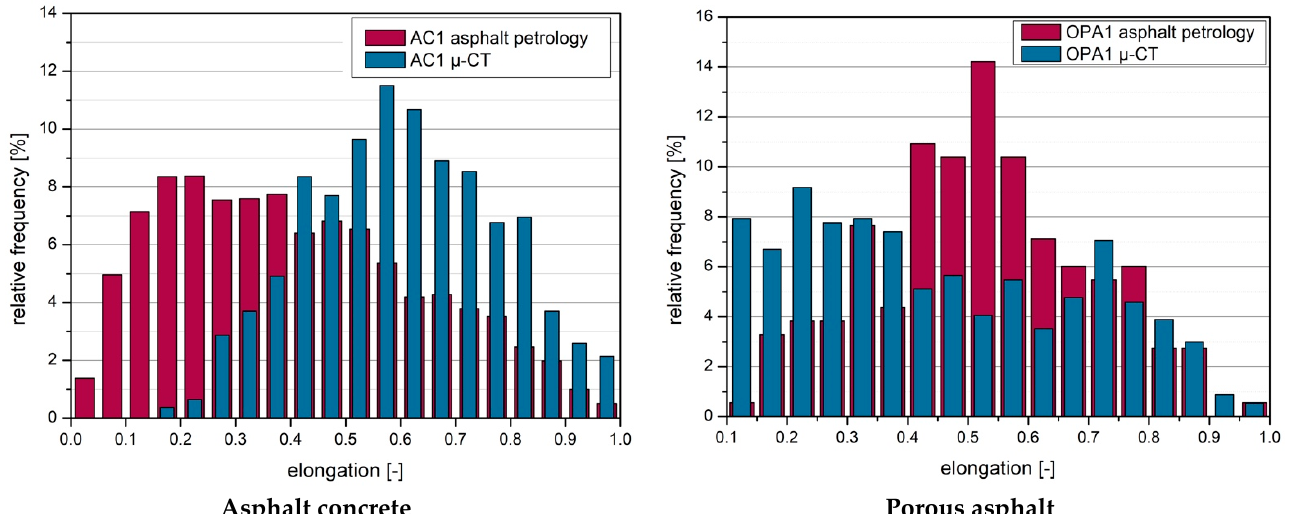
Figure 14. Comparison of elongation (2D method (asphalt petrology) and 3D method (µ-CT)).